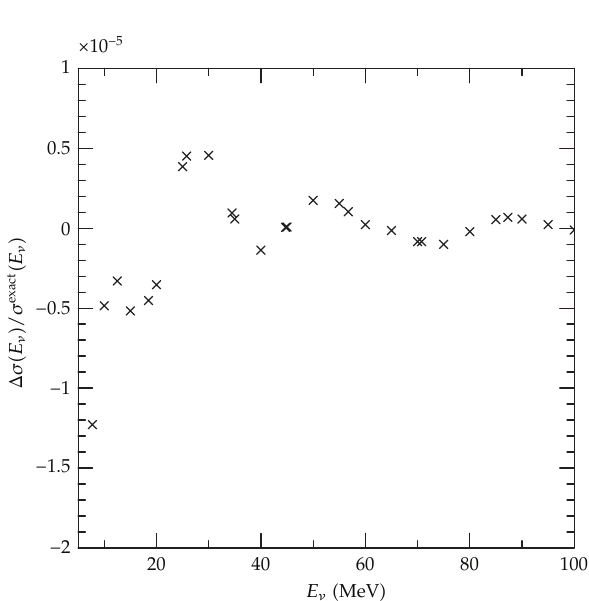
Figure 3: Same as Figure 2 for the charged-current antineutrino scattering o ff 100 Mo. Table 3: Averaged cross sections for the charged-current neutrino and antineutrino scatterings o ff 100 Mo in units of 10 − 41 cm 2 calculated for the two sets of neutrino parameters (cid:3) I and II (cid:4) displayed in Table 4.